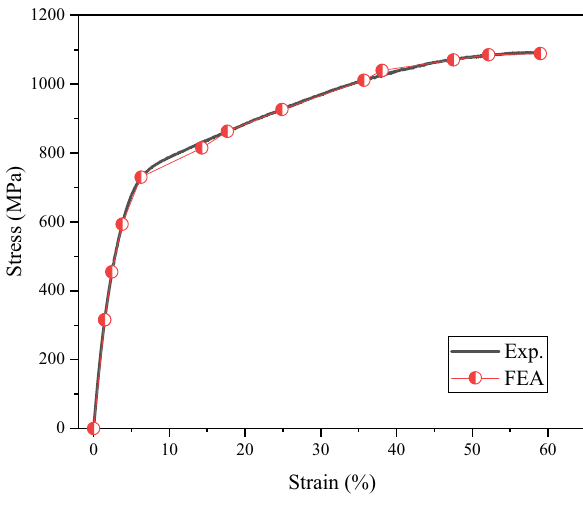
Figure 10: Modeling tensile behavior of SMA fi ber.